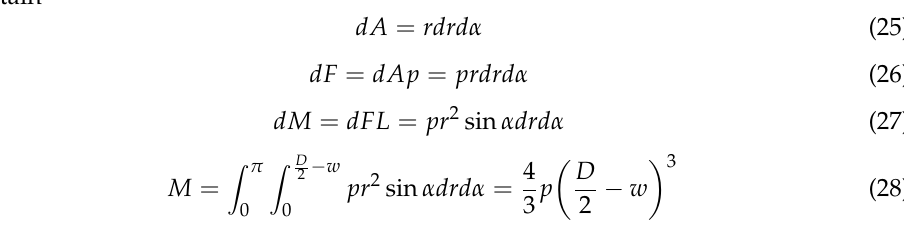
Figure 10. Mathematical model of the bending actuator. ( a ) Bending angle θ when left cavity’s air pressure is p . ( b ) The cross-section of the actuator.